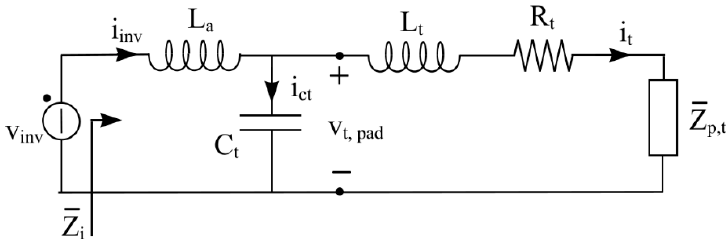
Figure 12. Equivalent circuit of the transmitter section. The feeding inverter is represented by an ideal sinusoidal voltage generator (the fundamental of the generated waveform), the impedance Z p , t represents the equivalent impedance of the receiving circuit referred to the transmitting one.